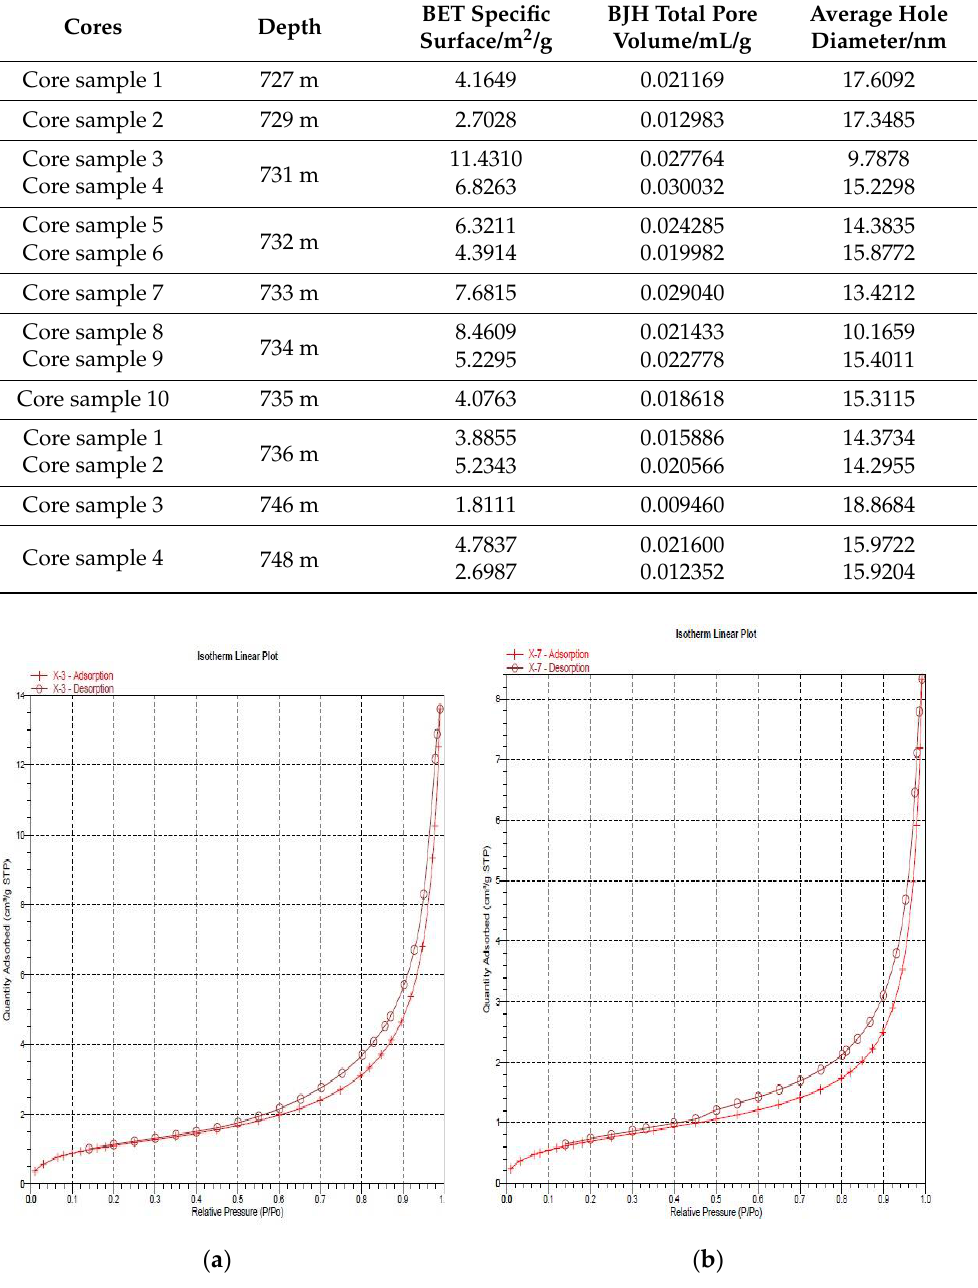
Figure 1. Nitrogen adsorption curves for core samples. ( a ) Core sample 1; ( b ) Core sample 2.